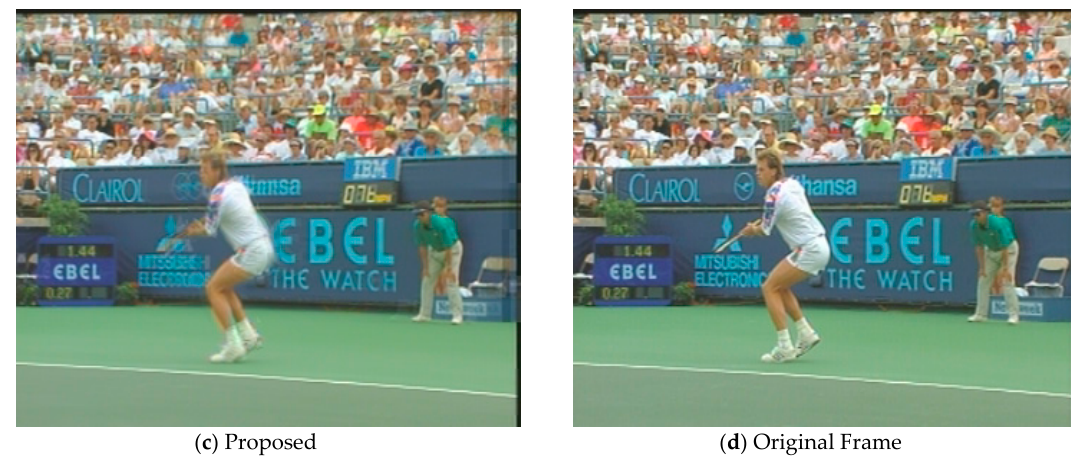
Figure 5. A visual comparison of the Stefan sequence between the three methods.